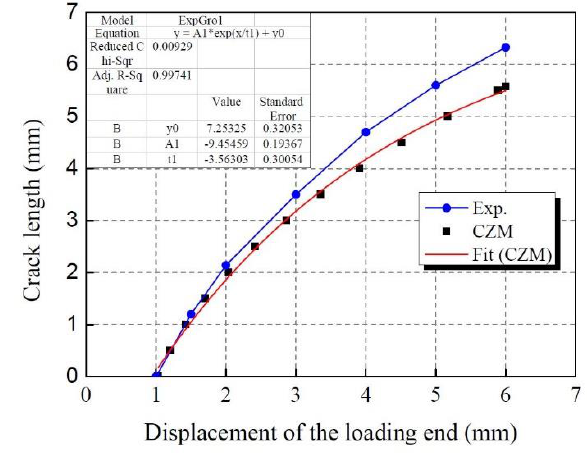
Figure 17. Simulated crack length curve compared to the experimental results.